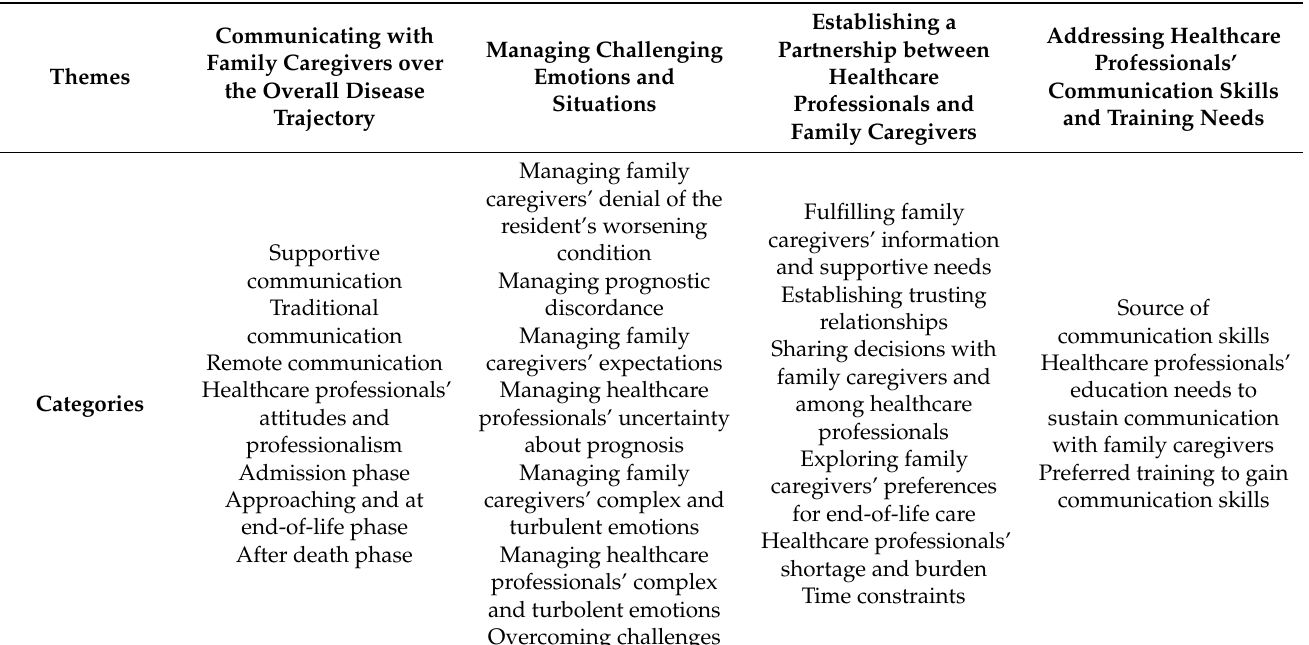
Table 3. Themes and categories emerged from interviews with healthcare